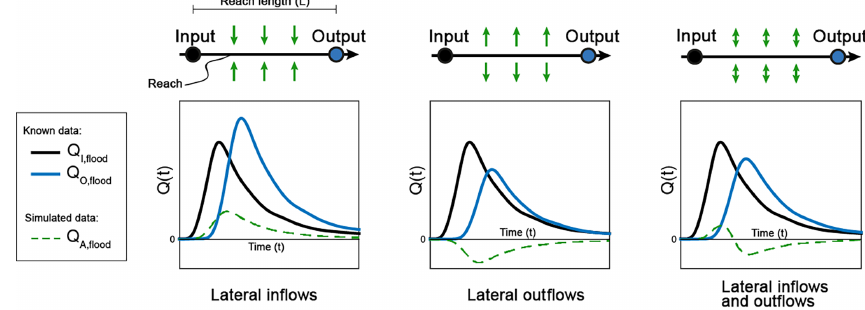
Figure 1. Diffusive wave equation to model lateral flood flow exchanges along a channel reach of length L . The black curve Q I , flood depicts the evolution of the flow rate with time at the beginning of the channel (input), and the blue curve Q O , flood at the end (output). The dashed green curve Q A, flood corresponds to the lateral flow exchanges which are positive for lateral inflows or negative for lateral